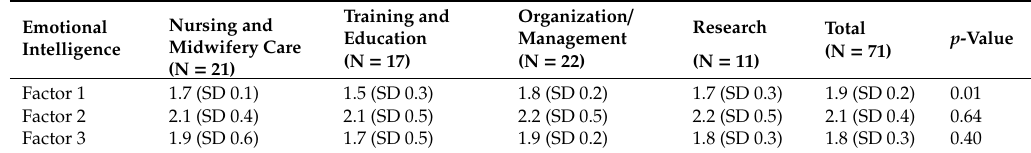
Table 6. Mean, standard deviation and p -value (ANOVA) of sample’s EI factors score, stratified by training activities.